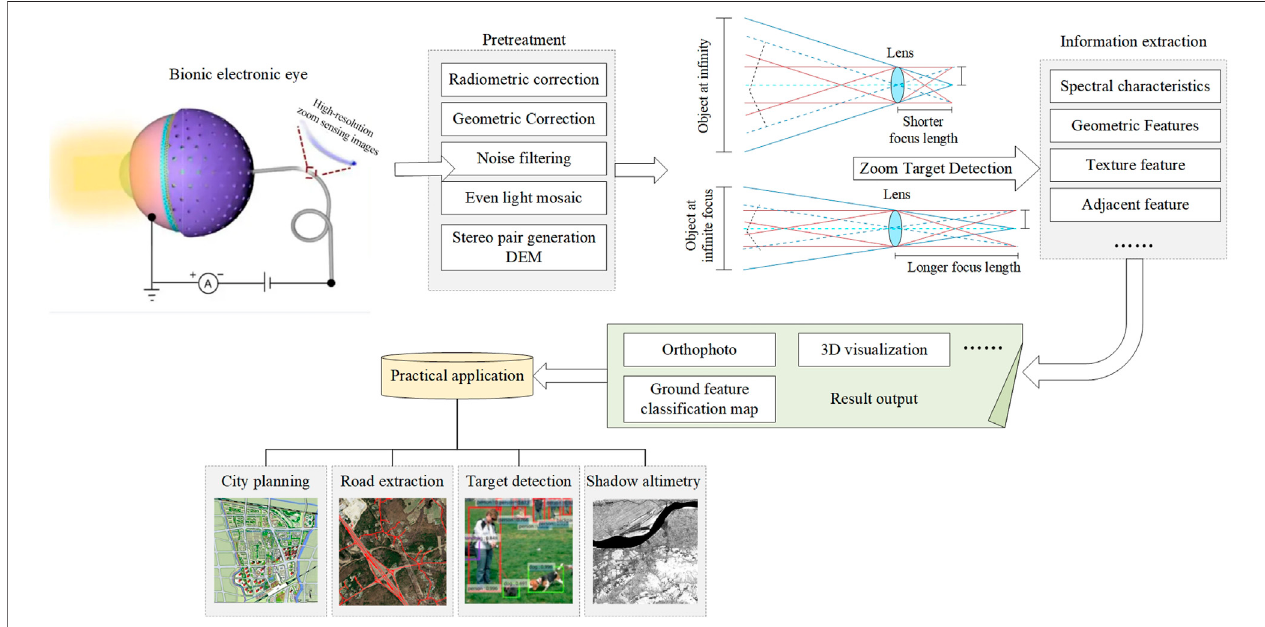
FIGURE 1 | High-resolution zoom image processing and application.